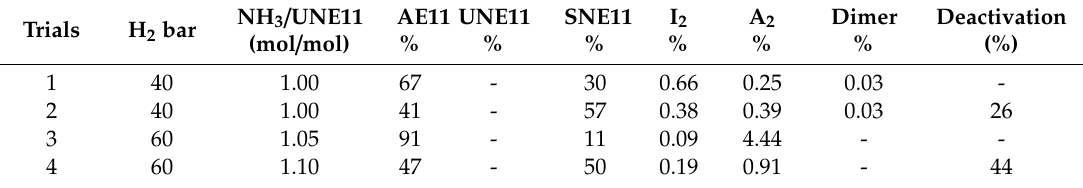
Table 2. Influence of H 2 pressure. Trial 1 and 3: first cycle catalyst hydrogenation of UNE11 at 40 and 60 bar H 2 atmosphere. Trials 2 and 4: Second cycle catalyst hydrogenation of UNE11 at 40 and 60 bar H 2 atmosphere without any type of reactivation. AE11: methyl-11-aminoundecanoate, UNE11: (9 Z )-10-cyano-9-decenoate, SNE11: methyl-10-cyanodecanoate. I 2 : secondary imine, A 2 : secondary amine, Dimer: dimer of the amino-ester (see Scheme 2 for molecular structure). Percentages of the reaction species were measured by GC–FID relative peak area.